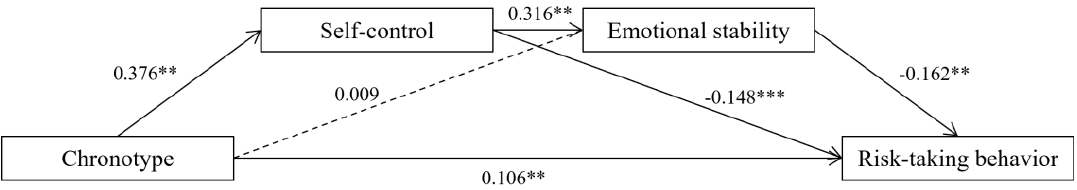
Figure 1. Model of the hypothesized mediator role of self-control and emotional stability in the relationship between morning–evening type and risk-taking behavior. All the path coefficients are standardized. ** p < 0.001, *** p < 0.001.